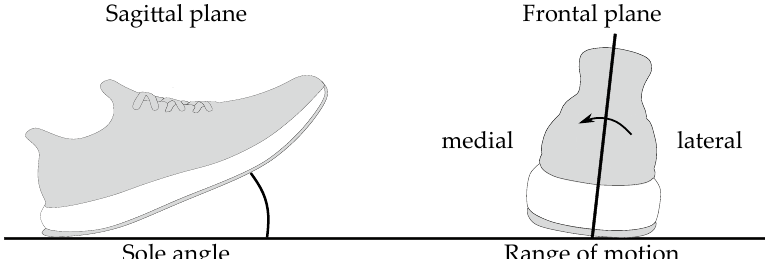
Figure 2. Visualization of sole angle and range of